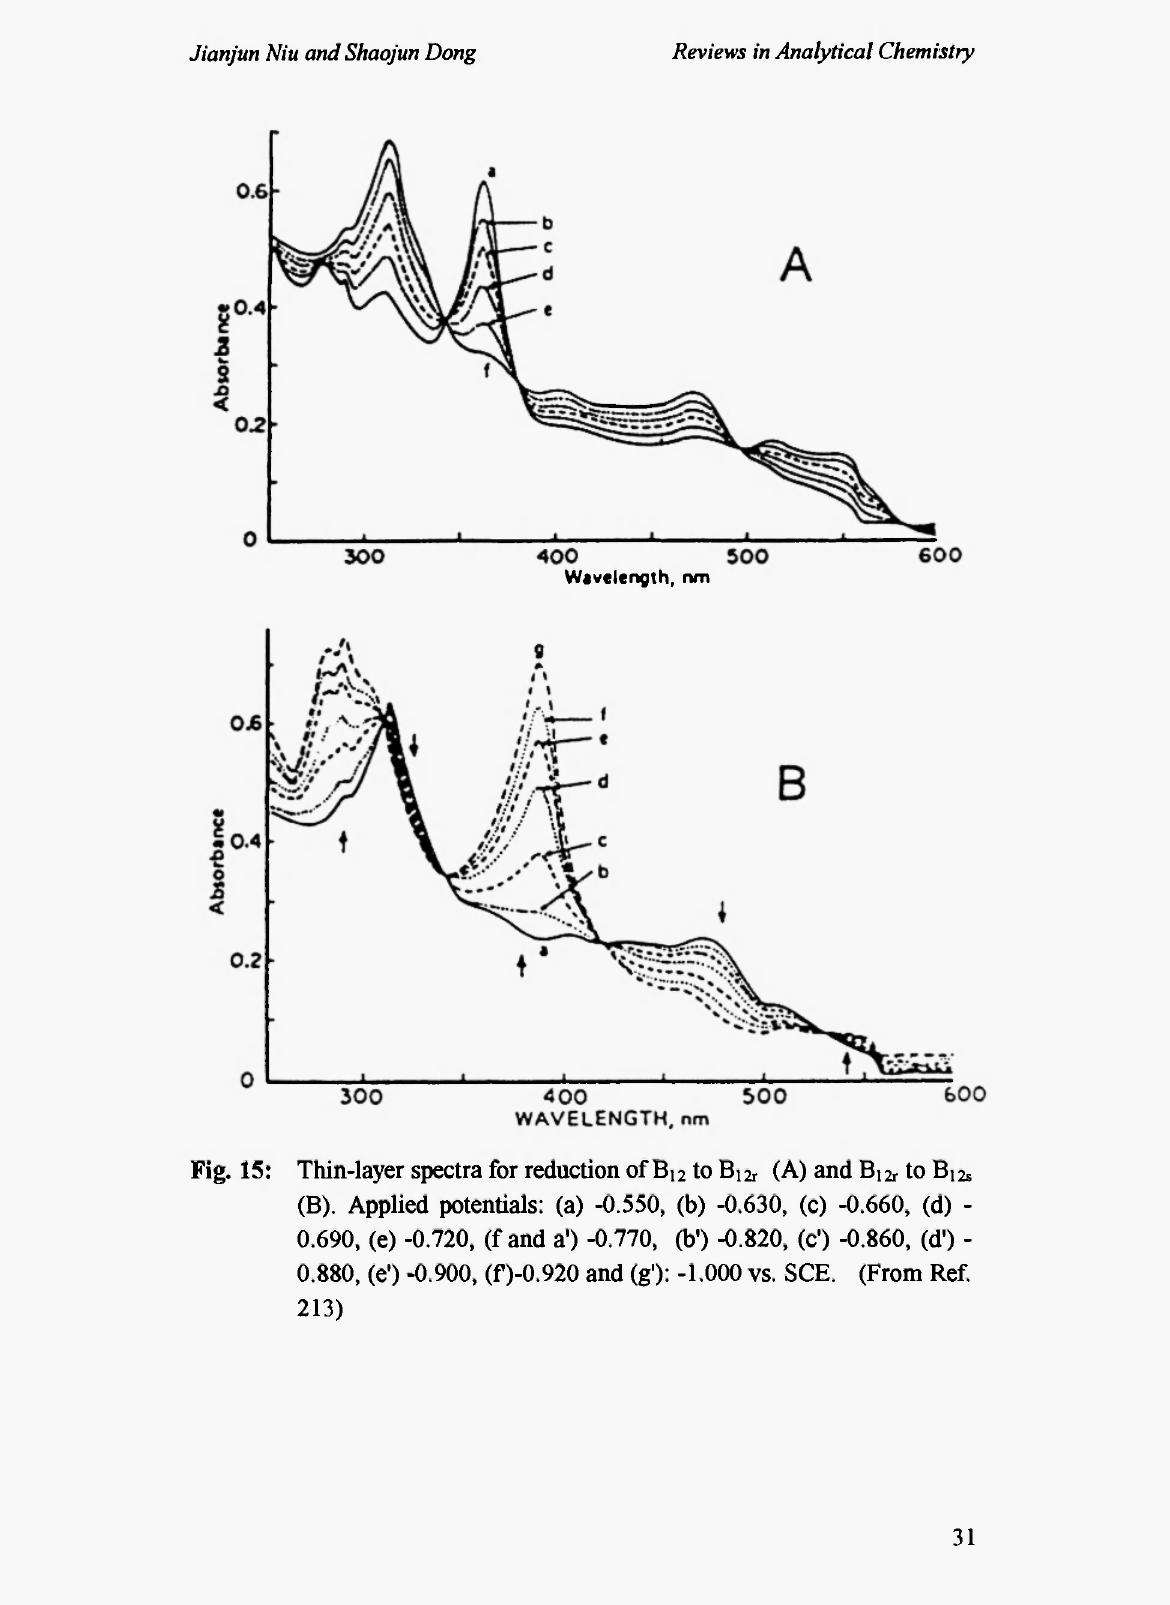
to B (A) and B to B 12 12r 12r 12s